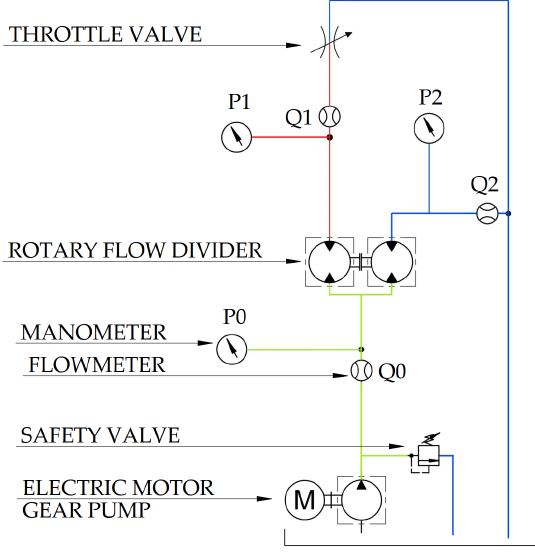
Figure 5. Hydraulic schema of measuring